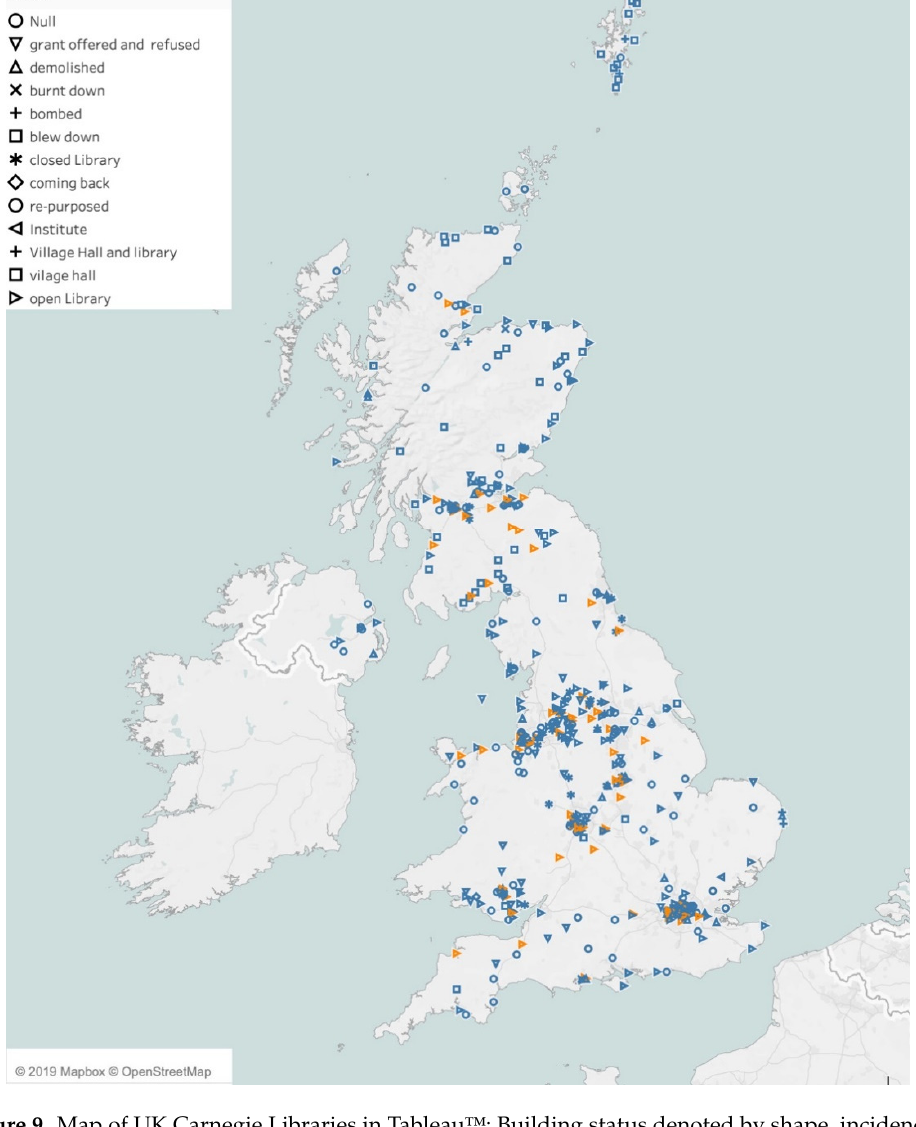
Figure 9. Map of UK Carnegie Libraries in Tableau ™ : Building status denoted by shape, incidence of barrel vaults by orange colour.